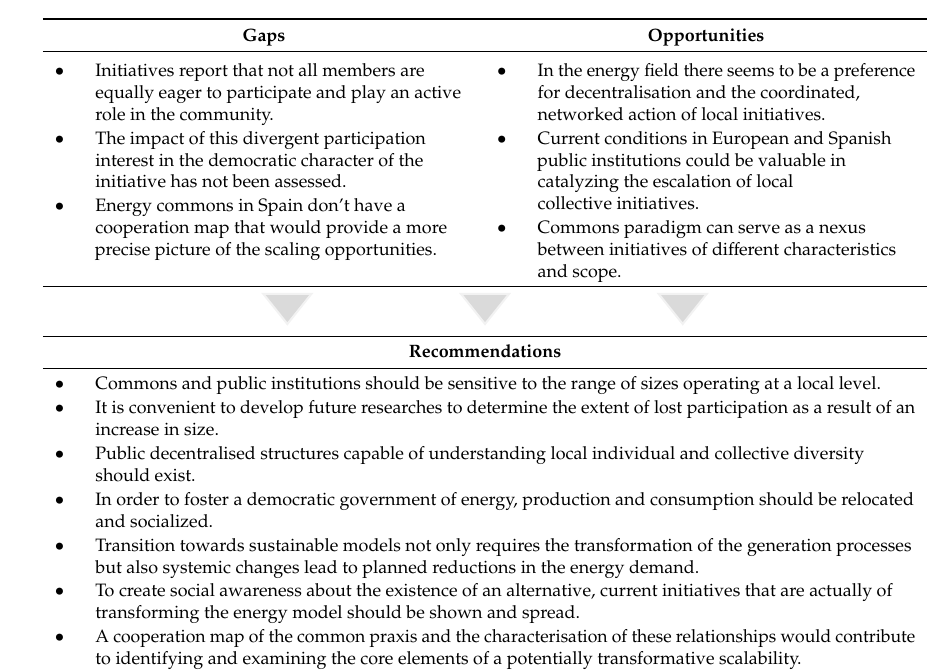
Table 3. Summary of the gaps, opportunities and recommendations.